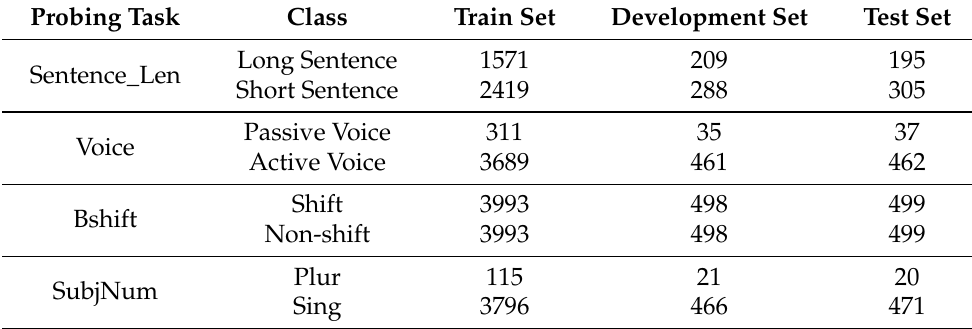
Table 1. The detail of the Chinese probing dataset derived from CoNLL2017. Probing Task